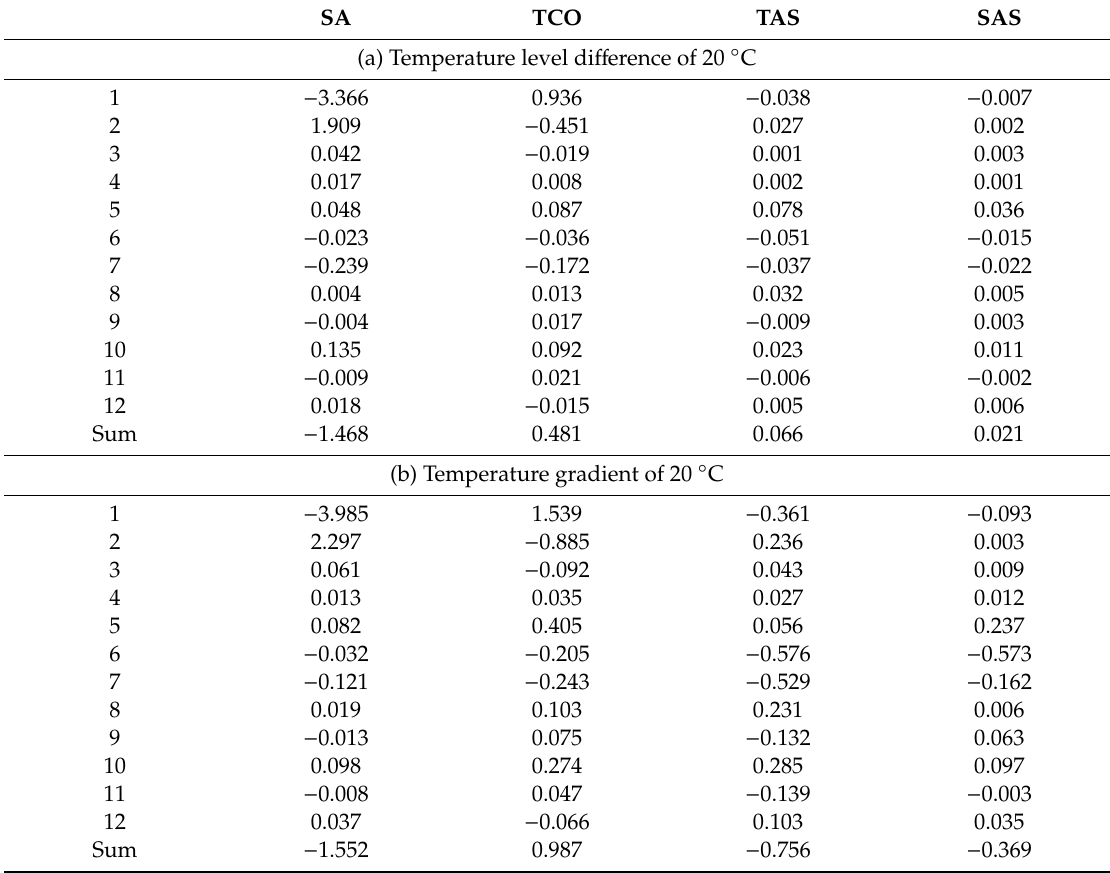
Table 2. Analysis of third-order